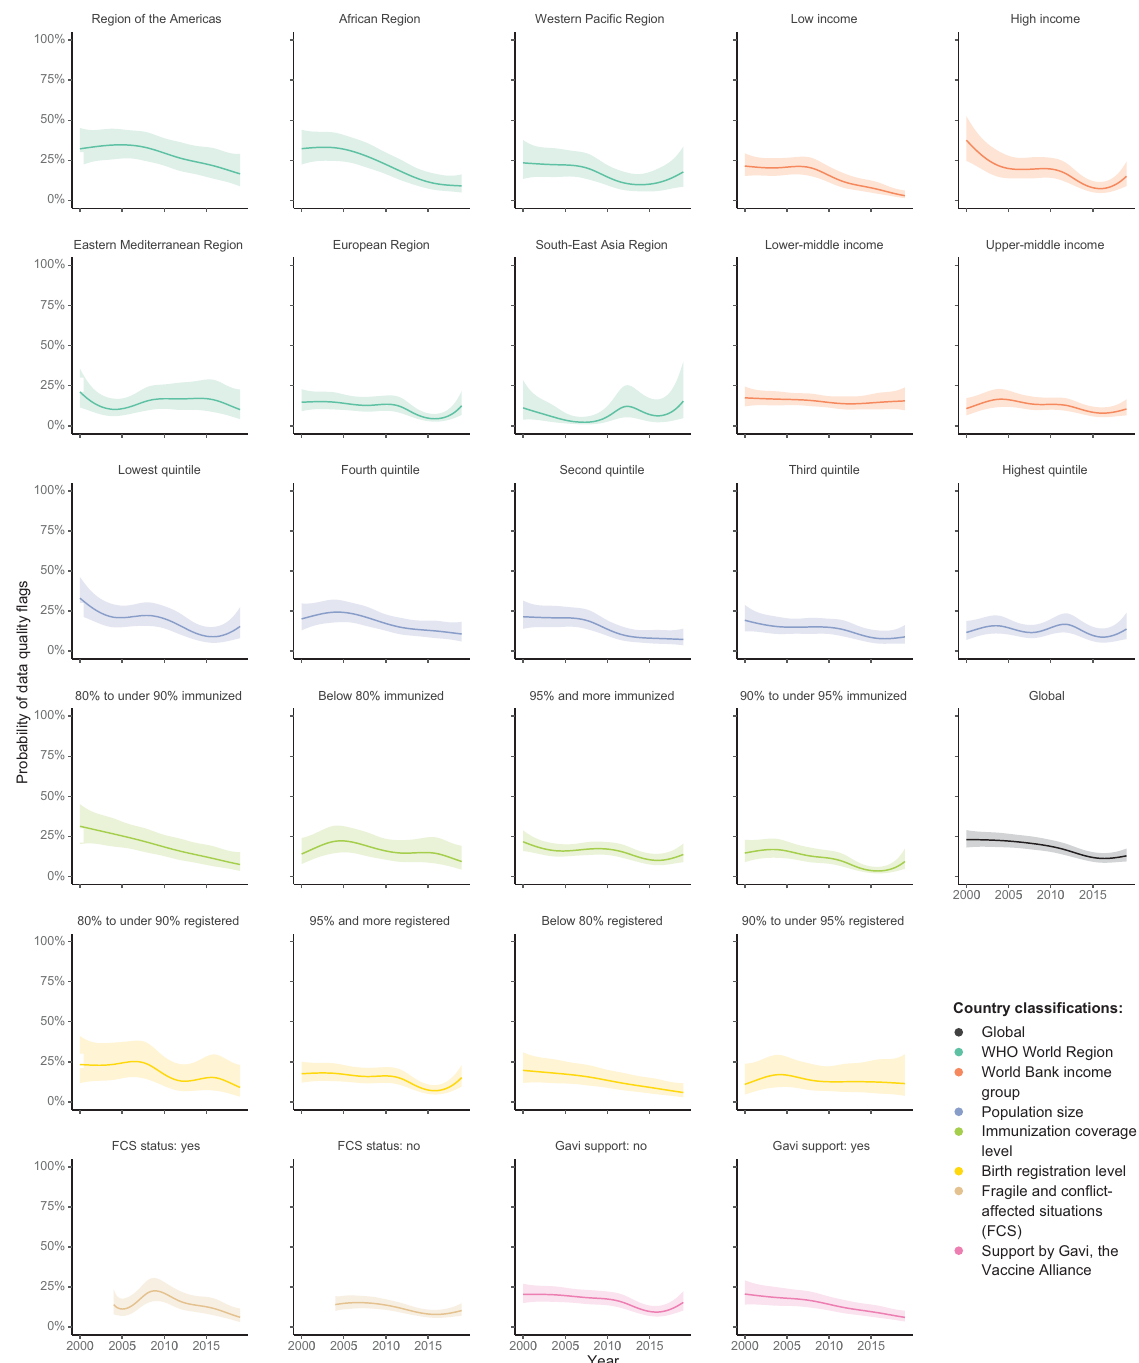
Fig 4. Modeled trends of the probability of data quality flags for immunization coverage reports for DTP1, DTP3, MCV1, and BCG, by different country classifications, 194 WHO Member States, 2000–2019. Notes: Shading represents 95% confidence intervals (CI). Country data as reported by 15 July 2020. BCG = Bacillus Calmette-Gue´rin vaccine birth dose. DTP1 = first dose of diphtheria-tetanus-pertussis- containing vaccine. DTP3 = third dose of diphtheria-tetanus-pertussis-containing vaccine. FCS = fragile and conflict-affected situations. MCV1 = first dose of measles-containing vaccine. Countries were grouped separately for each year by World Bank income groups, population size, and fragile and conflict-affected situations (FCS) classification. All other groupings were done for all years together. FCS status was available for 2004–2019 only. Immunization coverage level was based on average DTP1 and DTP3 coverage estimated by WHO and UNICEF for 2017–2019, as of July 2020. Birth registration levels refer to children under age five who have been registered based on the latest